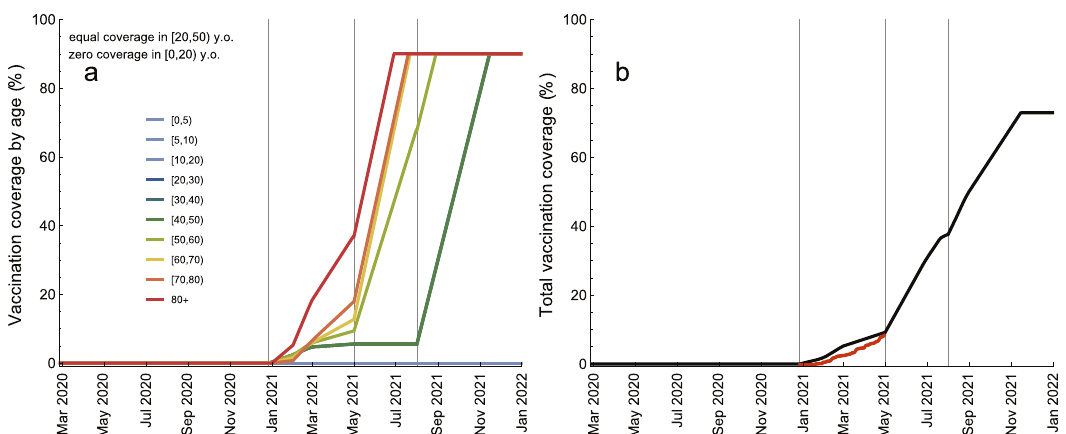
Fig. 5 Vaccination coverage during the vaccination rollout. a Age-speci fi c coverage (percentage of vaccinated persons per age group). b Total vaccination coverage (percentage of vaccinated persons in the population). The gray vertical lines indicate the starting dates for different vaccination phases (Table 1). The coverages for ages [20,30), [30,40), and [40,50) are equal (see Supplementary Fig. 4 for the absolute numbers of vaccinated persons). The coverage for ages [0,20) is zero. The vaccination rollout data based on fully vaccinated persons 1 are shown in b as red dots.